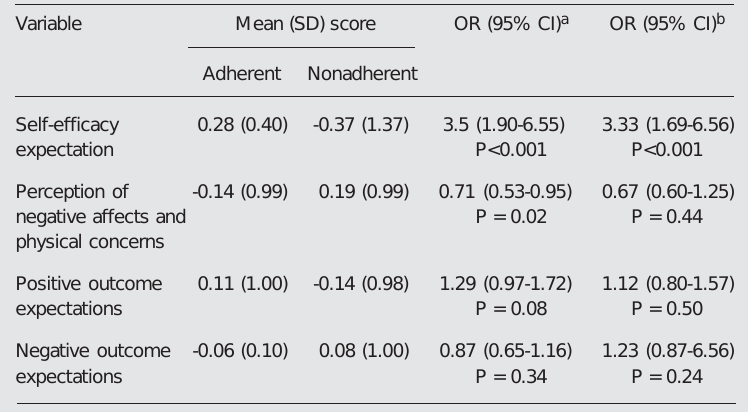
Crude odds ratios and adherence odds ratios adjusted for sociocognitive variables. a